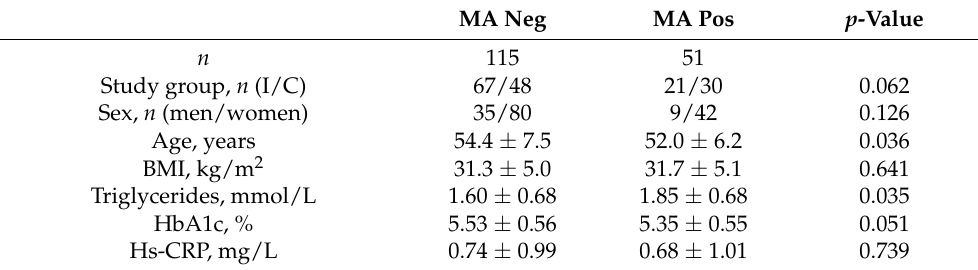
Table 1. Characteristics of the